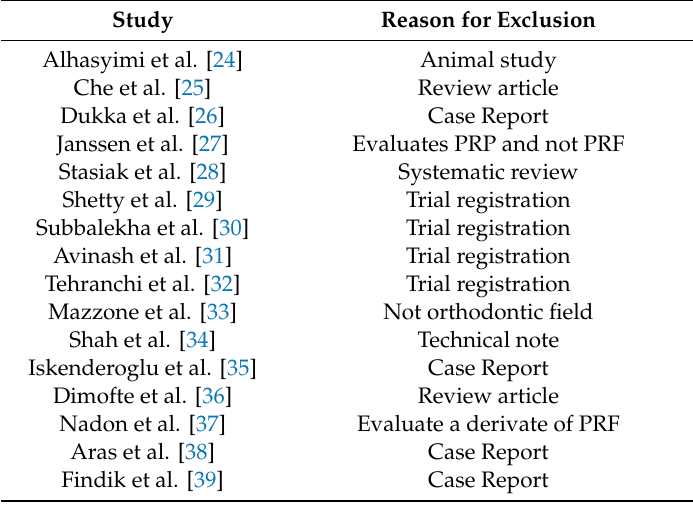
Table A4. List of excluded